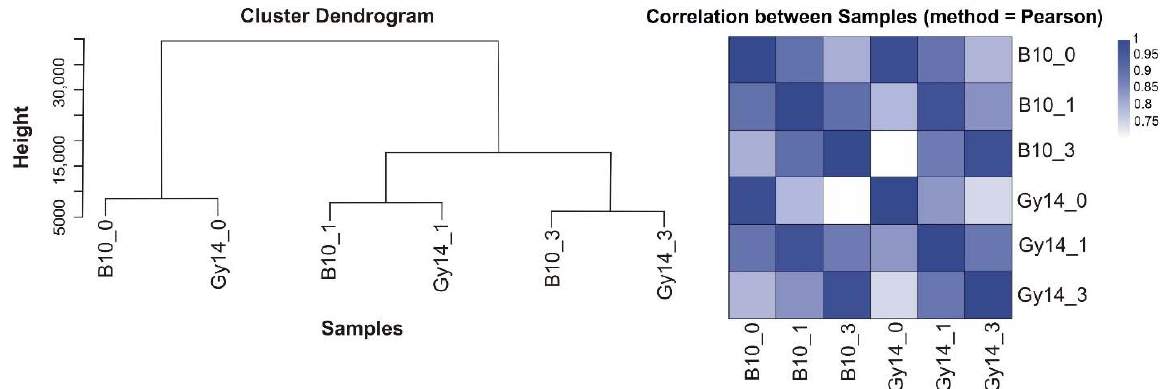
Figure 2. Hierarchical clustering and heatmap of Pearson’s correlation (R 2 ) between B10 and Gy14 lines inoculated with Psl 814/98 strain at 0, 1 and 3 dpi. ( A ) Hierarchical clustering between samples; ( B ) correlation matrix of expression profiles, both X-axis and Y-axis represent each sample. Correlated profiles are colored from blue to white (high to low correlation). Abbreviations: B10_0–B10 line at 0 dpi (control), B10_1–B10 line at 1 dpi, B10_3–B10 line at 3 dpi, Gy14_0–Gy14 line at 0 dpi (control), Gy14_1–Gy14 line at 1 dpi, Gy14_3–Gy14 line at 3 dpi.